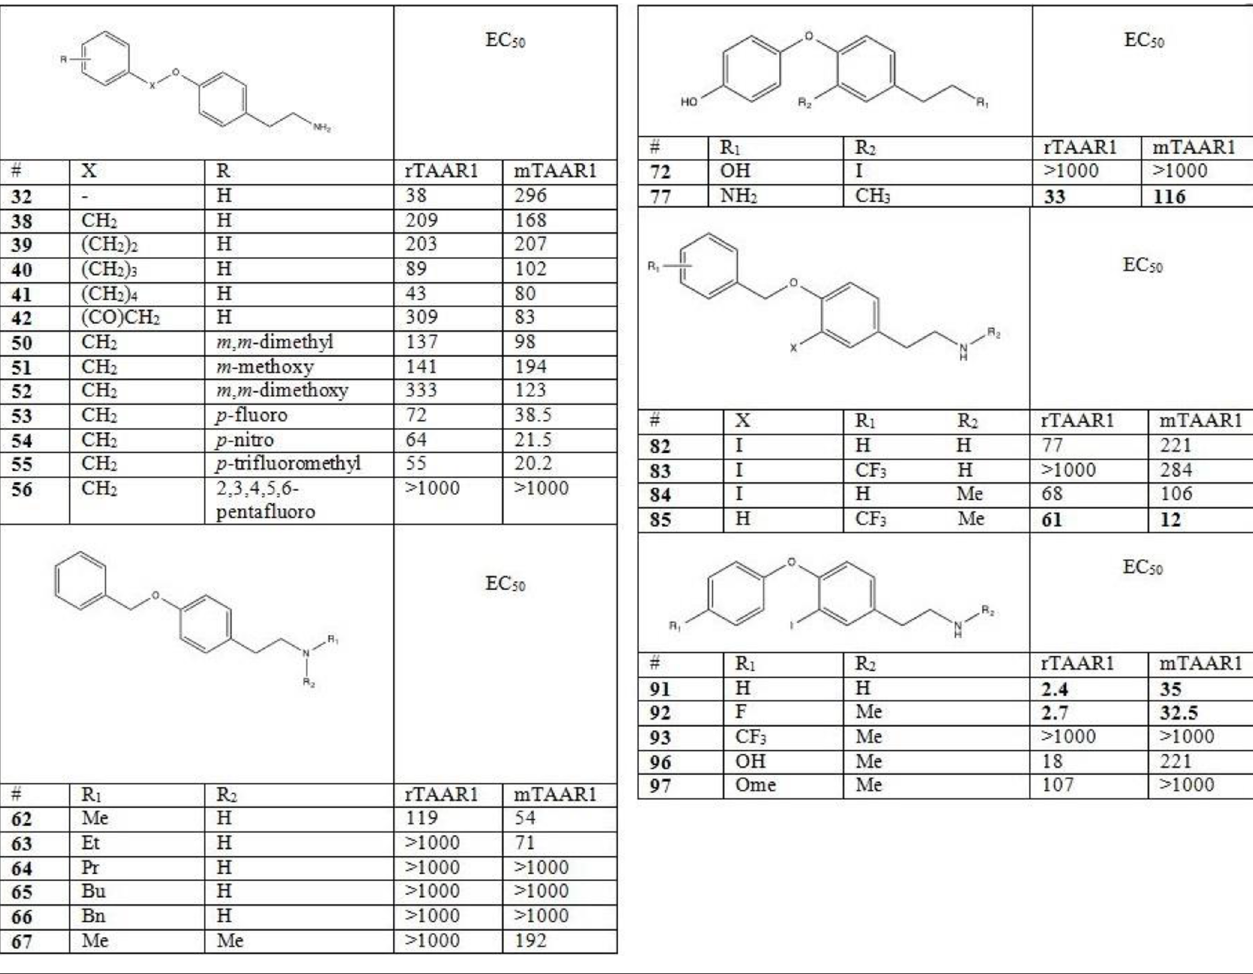
Concentrations are expressed as nM.